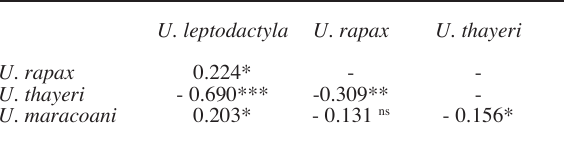
T ABLE 2. – Spearman’s rank correlation among Uca species col- lected at Pacoti River mangrove, northeast Brazil. * p < 0.05, ** p < 0.25, *** p < 0.001, ns p > 0.05.